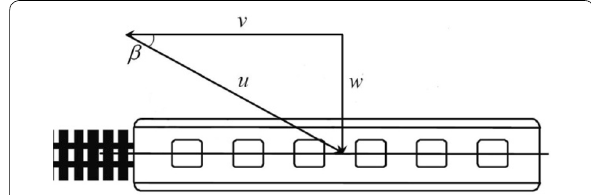
Figure 2 Velocity